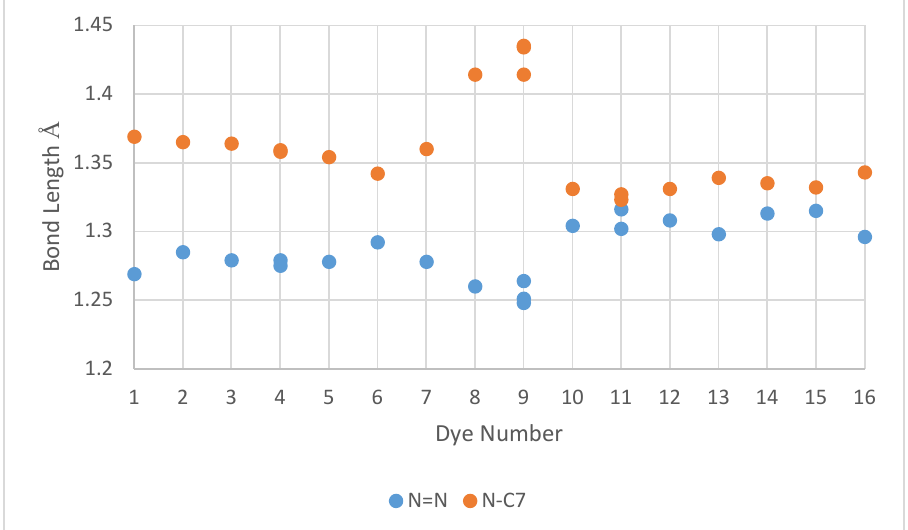
Figure 12. Bond lengths for N=N and N-C7 for all known free acid forms of monosulfonated azo dyes. The group para to azo for compounds 1 to 8 is OH, for 9 to 11 is NH x , 12 is NMe 2 , 13 and 14 is NEt 2 , and for 15 and 16 is N(CH 2 CH 2 OH) 2 .